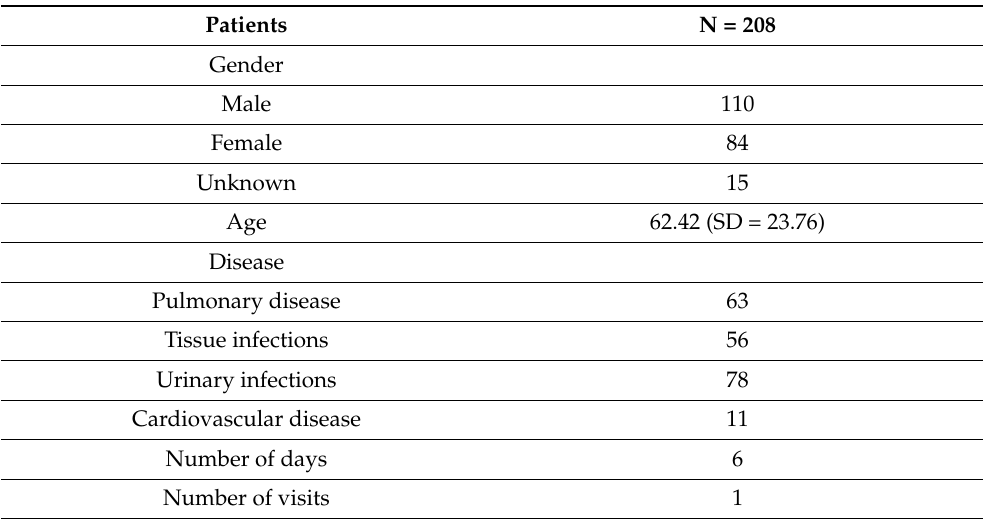
Table 5. Sociodemographic characteristics of patients, including number of days in the HaH unit and number of visits by health